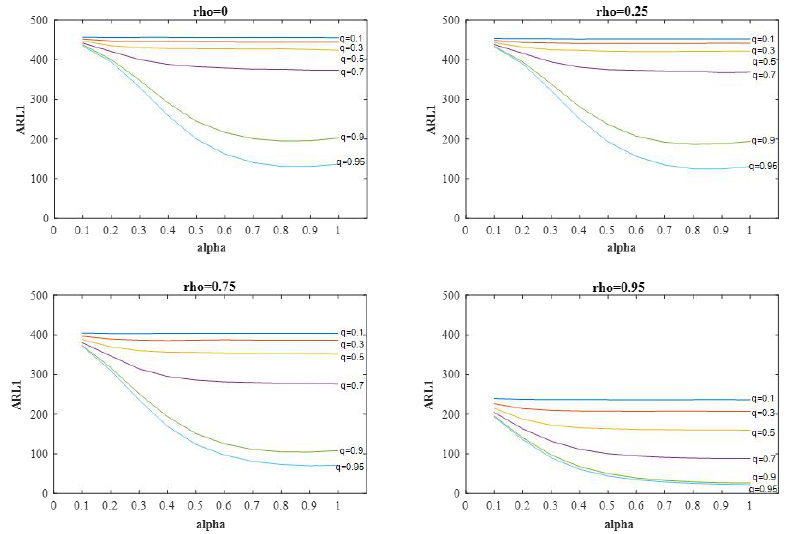
Figure 2. Curves of the AIB-GWMA-t charts with various correlation coe ffi cients at small process mean Figure 2. curves of the AIB‐GWMA‐t charts with various correlation coefficients at small process shift δ = 0.1. mean shift 0.1   .